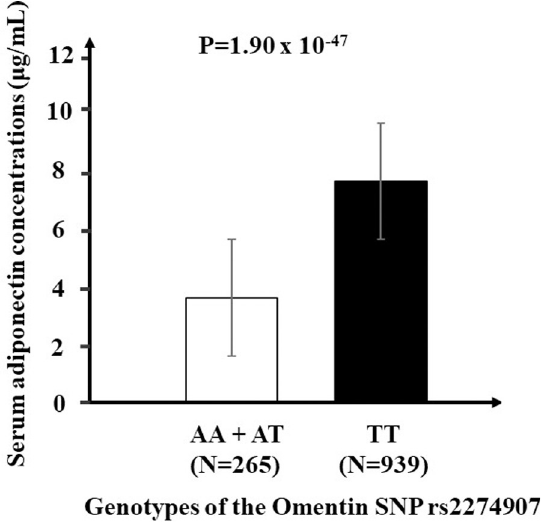
Fig 2. Association between omentin SNP rs2274907 with serum adiponectin concentrations. After adjusting for age, sex, BMI, WC and cardiometabolic health status, the ‘A’ allele carriers (AA + AT) have significantly lower levels of serum adiponectin concentrations compared to those with TT genotype (p = 1.90 x 10 − 47 ). Abbreviations: BMI, Body mass index; WC, waist circumference; SNP, Single nucleotide polymorphism.